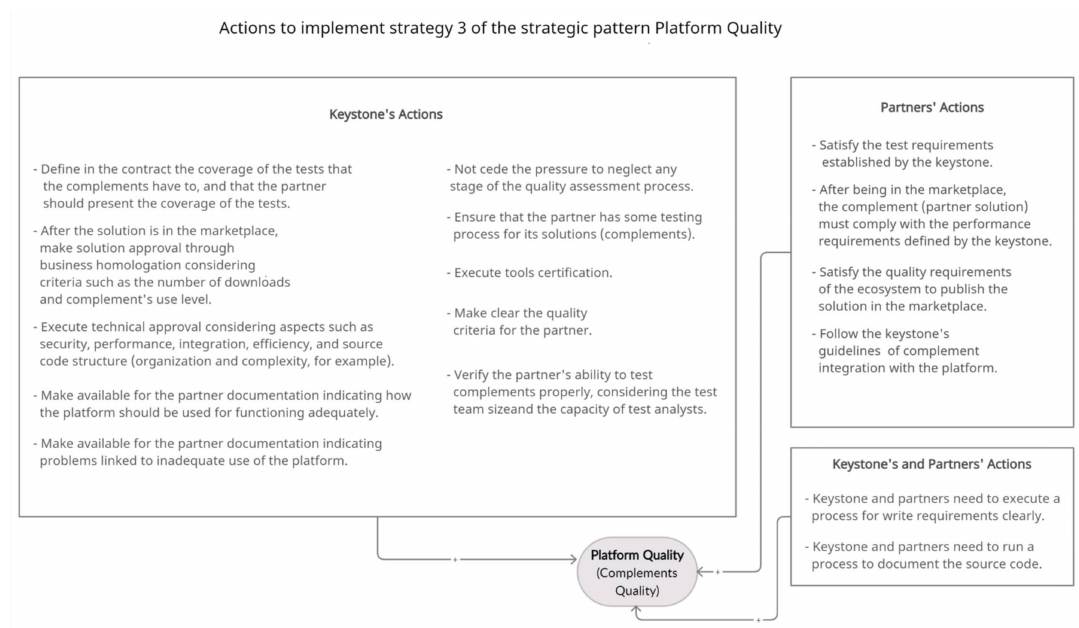
Figure 10. Result of the analysis of the interviews about the quality of the platform: actions that positively impact the platform quality (complements